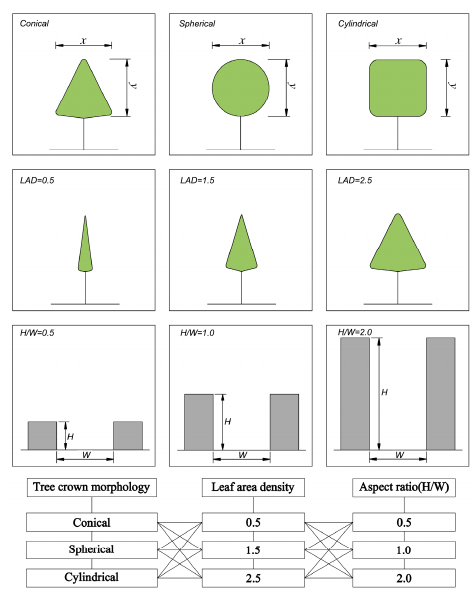
Figure 4. Case setting (27 cases were set by combining tree crown morphologies with three levels of